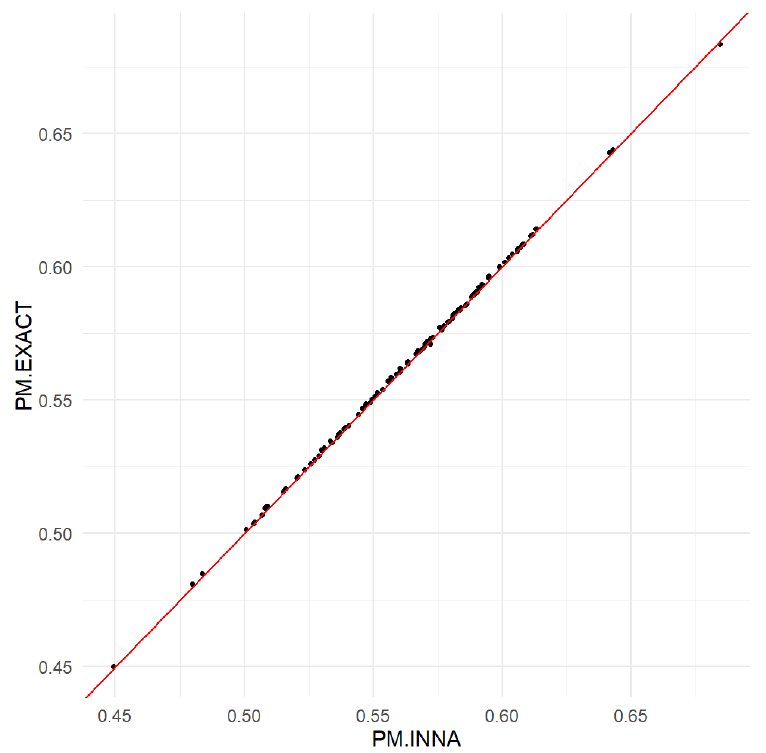
Figure 4. Comparison of the INNA method and the exact method using the PMs of the ward proportions.